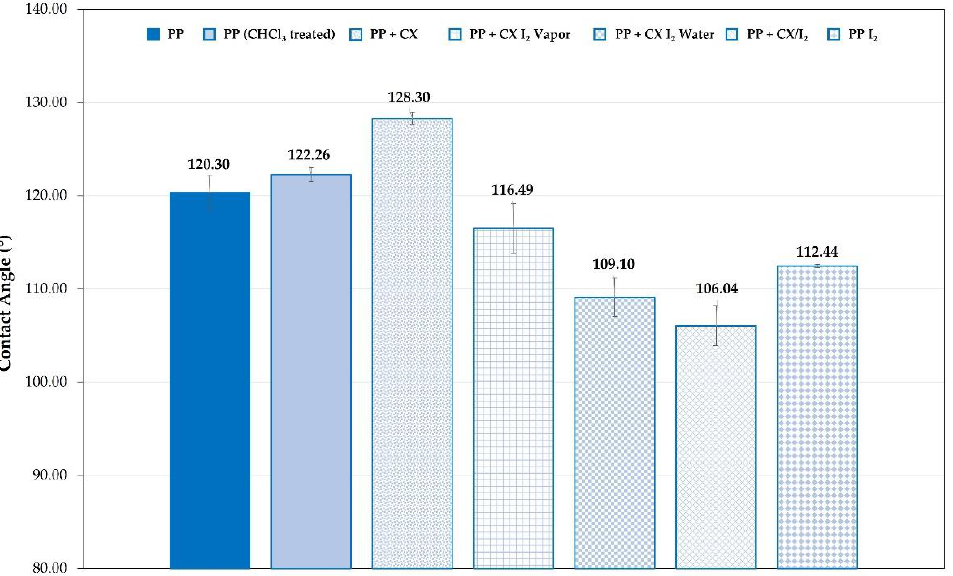
Figure 10. SCA of PP strip samples unmodified and embedded with iodine, CX, or its iodine com- plex.